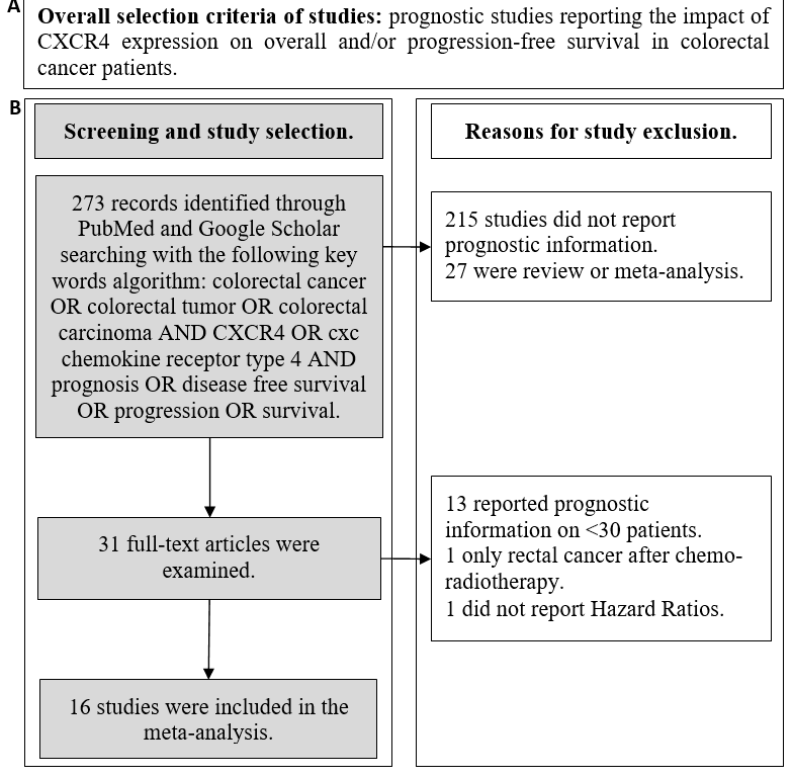
Figure 1. Overall selection criteria for study selection ( A ). Detailed flowchart reporting the criteria for study selection and exclusion ( B ).